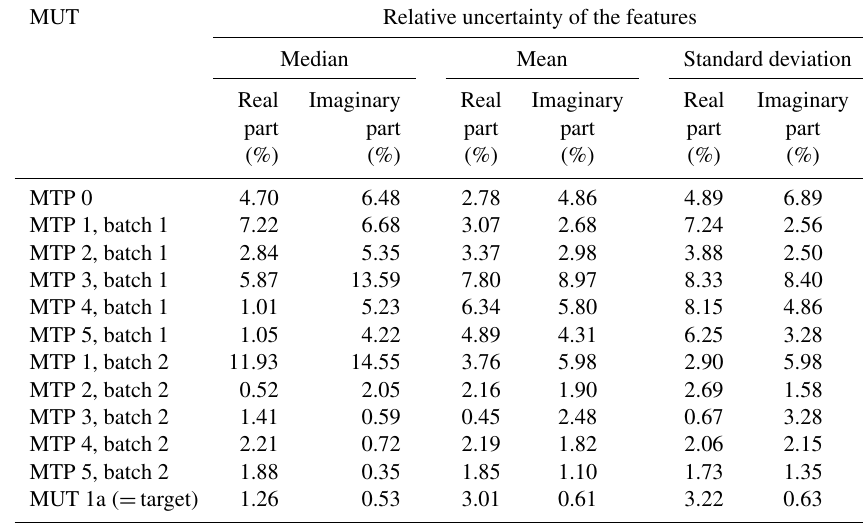
Table 6. Relative uncertainties of the features for monitoring the used-sand regeneration, at a confidence level of 95%.